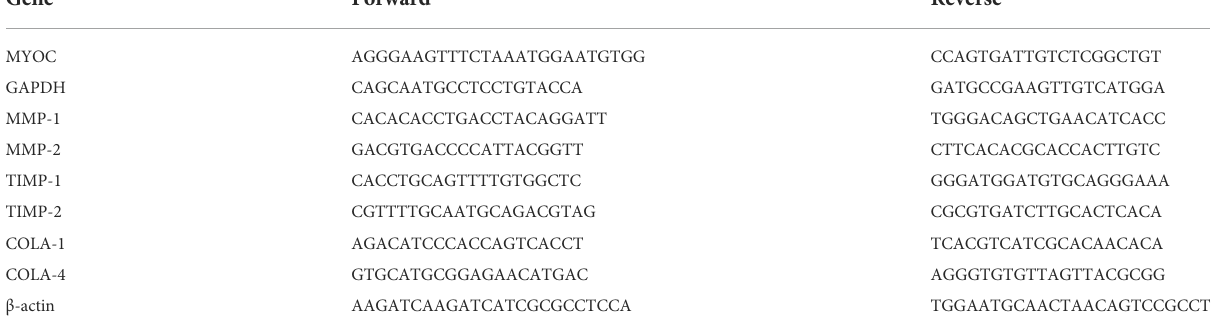
TABLE 2 Sequence of the primers used for